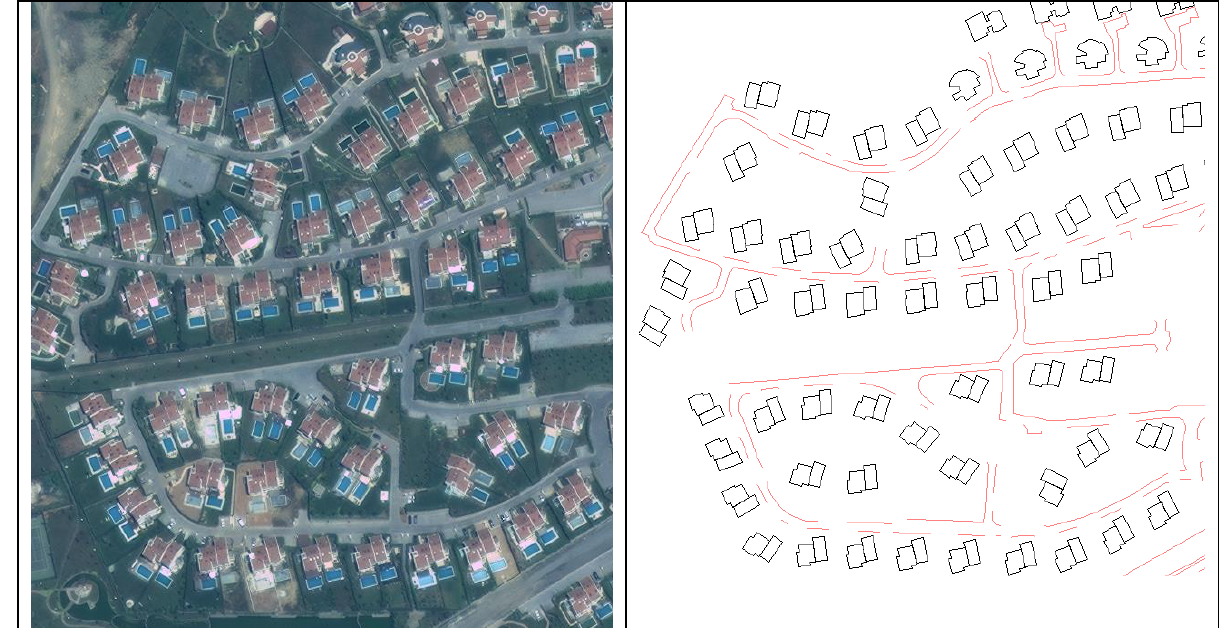
Figure 10. Object comparing with Worldview-2(left) image and 1/5000 scale Topographic map (right) in the area of the